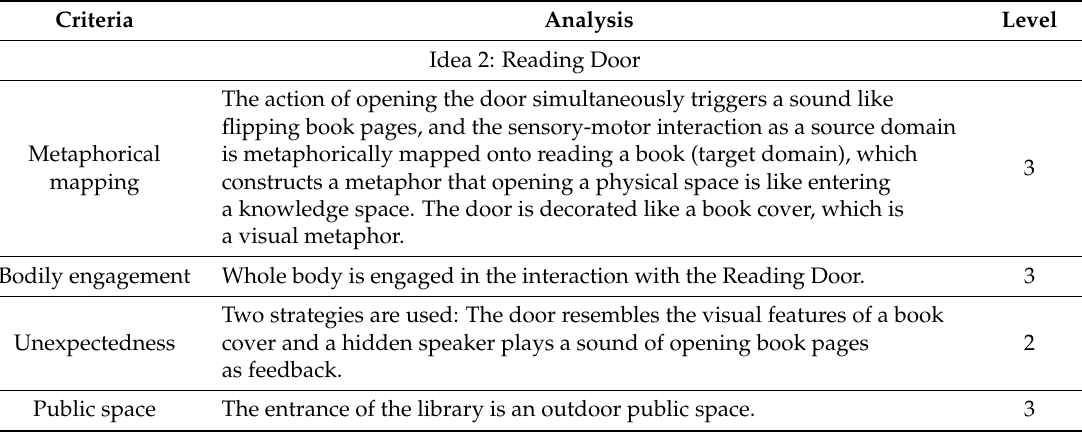
Table 3. Analysis of Reading Door.